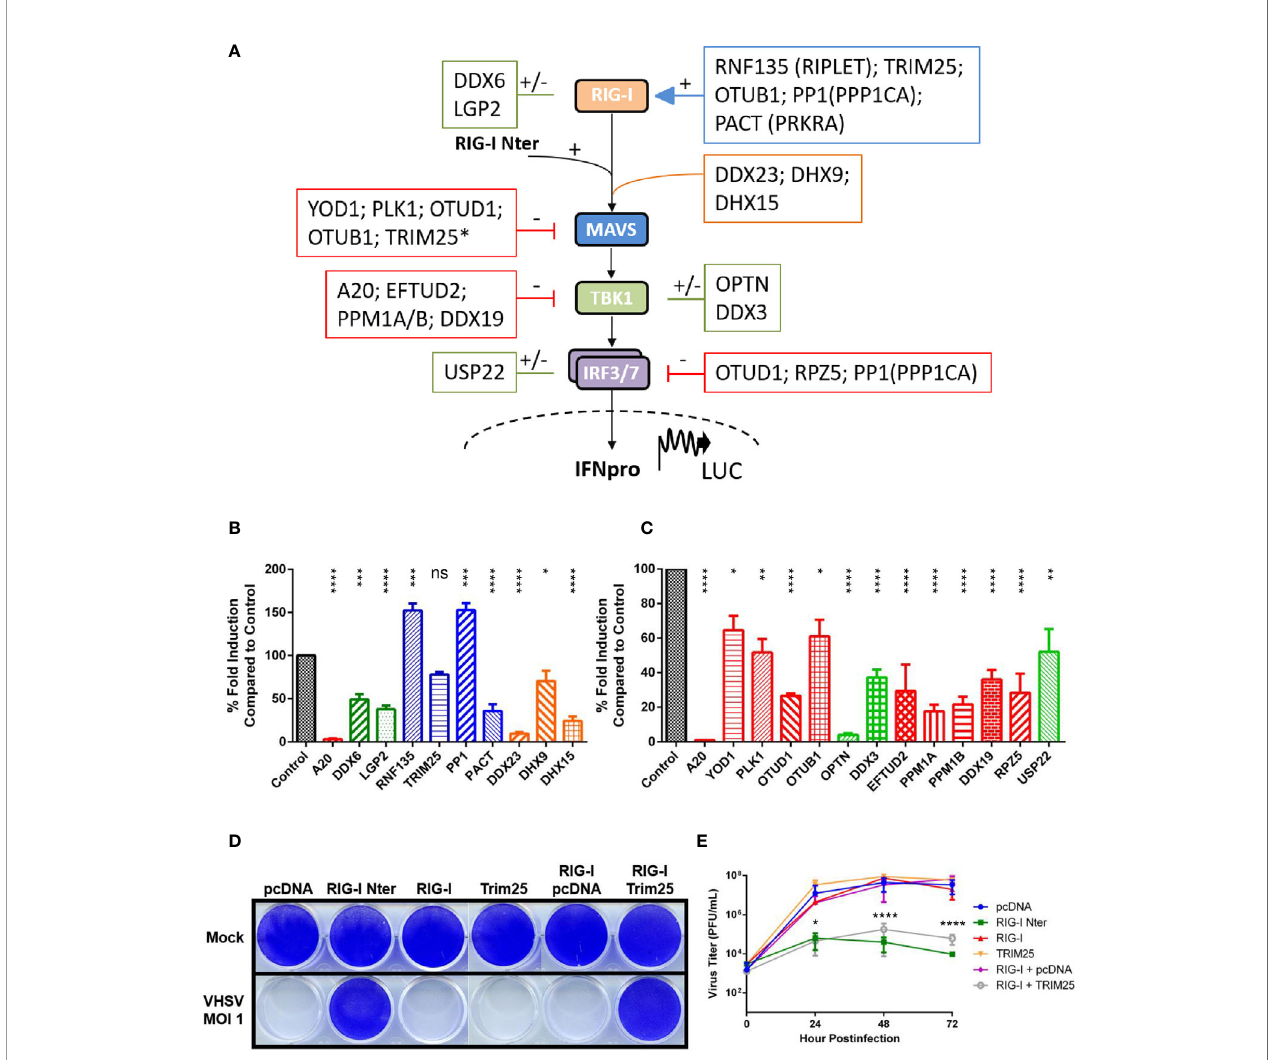
FIGURE 1 | Regulation of RIG-I-mediated signal transduction by a conserved set of cellular proteins in vertebrates. (A) Schematic representation of RIG-I pathway including the main downstream components for signal transduction leading to promoter activation and expression of type-I interferon. A set of cellular regulators that are evolutionarily conserved between fi sh and mammalian species are placed next to their targets. The effect of each regulator is symbolized by ( – ) for inhibition (in red), by (+) for activation (in blue), or by (+/-) for ambivalent (in green) reported functions on the RIG-I pathway, based on the literature (mainly from studies with mammalian orthologs; see Table 1 ). Other cytosolic sensors or co-receptors involved in the RIG-I pathway are boxed in orange. *Although TRIM25 promotes the degradation of MAVS, this step is required for IRF3 phosphorylation by TBK1 (23). (B, C) Fathead minnow orthologs of mammalian regulators were ampli fi ed from total RNA extracted from EPC cells, cloned into the eukaryotic expression vectors pcDNA1.1/Amp (Invitrogen) and fully sequenced. Nucleotide sequences of each regulator were deposited in GenBank (see Table 1 for accession numbers). To test their effect on the RIG-I pathway, EPC cells were transfected with the indicated plasmids (1 m g) together with a luciferase reporter construct driven by the promoter of IFN1 derived from EPC cells (1 m g) and the RIG-I Nter-eGFP inducer and internal transfection control construct 0.5 µg in (B) or 1 m g in (C) , as previously described (24). Twenty-four hours after transfection, the cells were lysed for luciferase assays. Luciferase activity was measured and normalized to eGFP fl uorescence. No signi fi cant variation in eGFP expression was observed between each condition. The percentage of fold-induction were calculated as the ratio of stimulated (+ RIG-I Nter) versus unstimulated ( − RIG-I Nter) conditions and compared to the induction control (RIG-I Nter + empty vector). Means of at least three independent experiments are shown together with the standard errors. The color coding used for the histograms is the same as the one used in panel (A) For statistical analysis, a comparison between groups was performed with a one-way ANOVA and Tukey ’ s multiple comparison tests using GraphPad Prism (GraphPad, San Diego, CA). Groups that are not signi fi cantly different from each other are denoted ns (P > 0.05), whereas those that are signi fi cantly different are denoted *(P < 0.05), **(P < 0.01), ***(P < 0.001) or ****(P < 0.0001). (D, E) EPC cells were transfected with the indicated plasmids (2 m g each) or an empty vector (pcDNA1.1/Amp) as a control, as previously described (25). All transfection mixtures were adjusted with an empty vector to contain an equal amount of plasmid DNA. Twenty-four hours after transfection, cells were infected with a fi sh novirhabdovirus, viral hemorrhagic septicemia virus (VHSV) at an MOI of 1 and incubated at 15°C. Cell monolayers were stained with crystal violet 3 days postinfection (D) . The culture supernatants from infected cells were collected at different times postinfection and the viral titer was determined by plaque assay (E) . Each time point is represented by two independent experiments, and each virus titration was performed in duplicate. Average values are shown. The standard errors were calculated and the error bars are shown. Asterisks indicate signi fi cant difference (*p < 0.05; ****p < 0.0001) as determined by two-way ANOVA and Tukey ’ s multiple comparison tests. ns, not signi fi